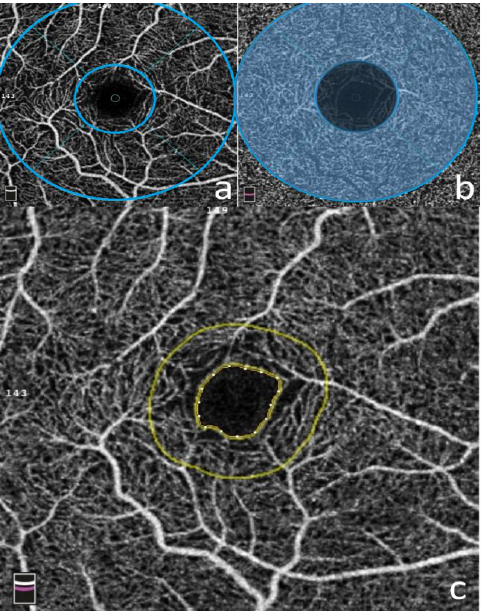
Figure 1. OCTA Software. Optovue RTVue XR Avanti 2017.1 (3 × 3 mm macula cube) software was used to analyze retinal microvasculature. Figure 1a represents superficial capillary plexus en- face image with 1mm and 3 mm rings surrounding fovea (blue). Figure 1b represents an image of the deep capillary plexus with 1–3 mm annulus representing the parafoveal region